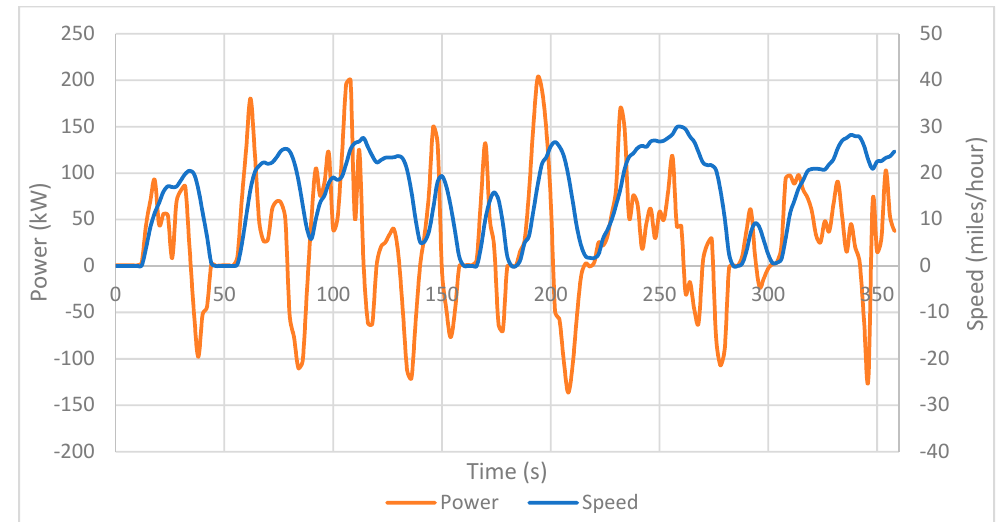
Figure 4. Power and speed traces of the peak power profile.